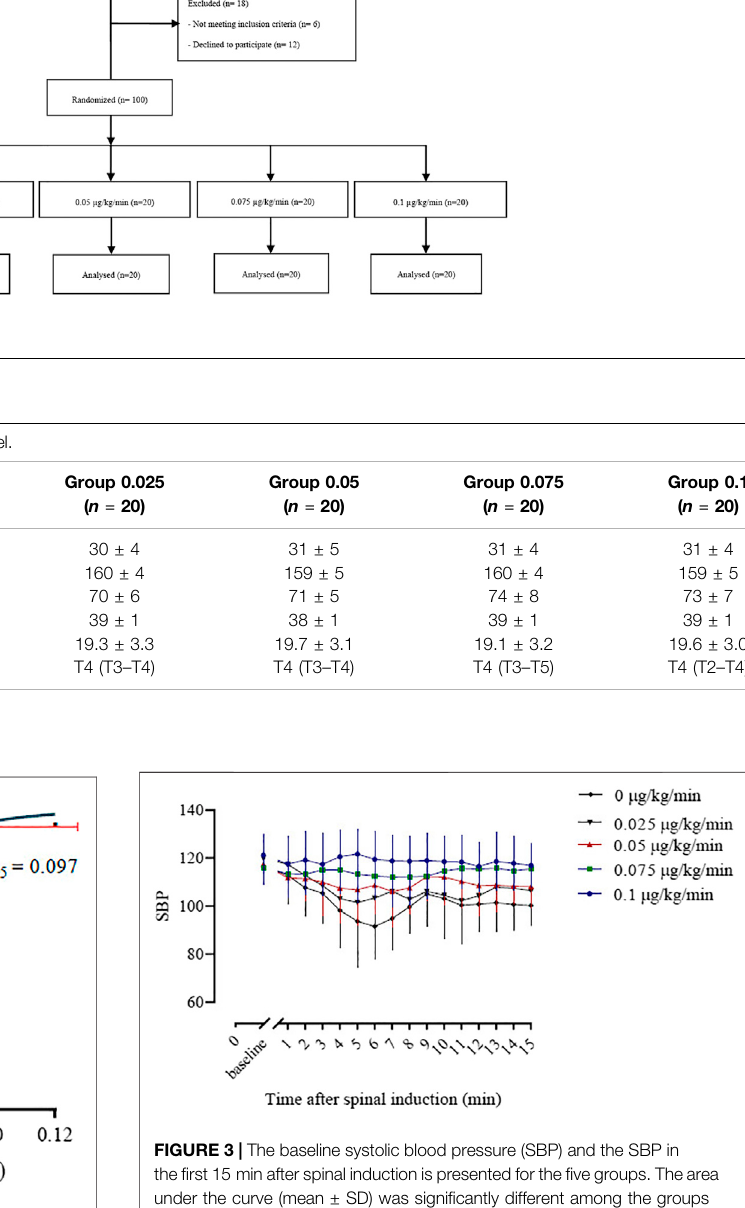
FIGURE 2 | The dose-response curve of norepinephrine for preventing spinal anesthesia-induced hypotension. The ED50 and ED90 were 0.042 (95% CI, 0.025 – 0.053) µg/kg/min and 0.097 (95% CI, 0.081 – 0.134) µg/kg/ min, respectively.